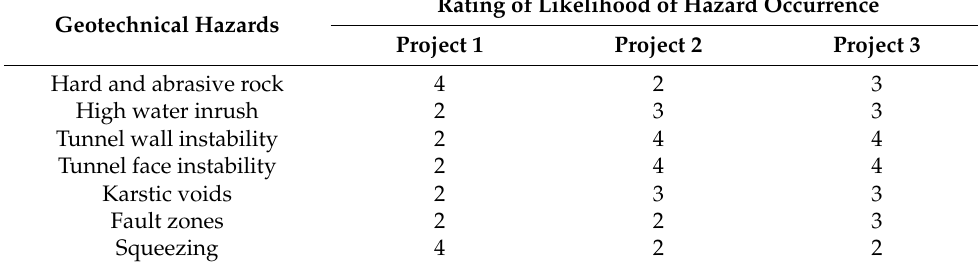
Table 20. Rating of likelihood of hazard